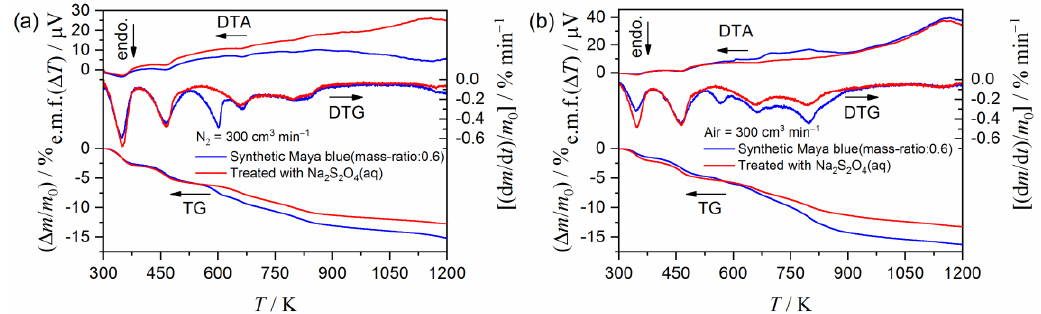
Figure 3. Comparison of the TG–DTG–DTA curves for the heat-treated indigo / palygorskite samples before and after treatment with Na 2 S 2 O 4 (aq) recorded in ( a ) flowing N 2 and ( b ) flowing air.